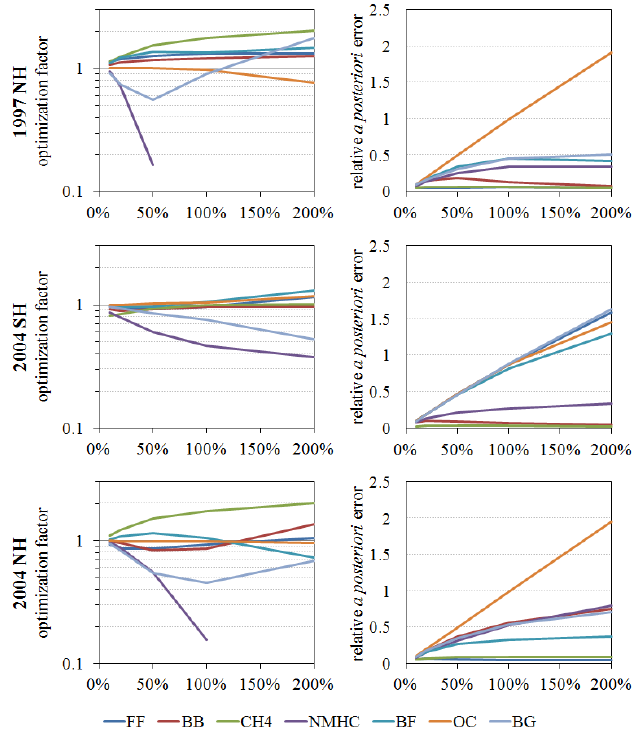
Figure 6. Inversion results (optimization factors and a posteriori errors) of each source with different a priori source uncertainties. A logarithmic scale is used for optimization